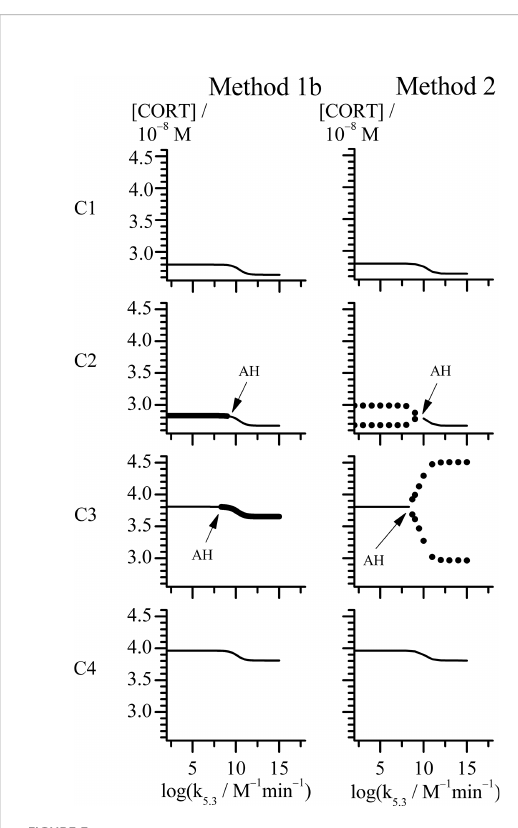
FIGURE 3 Bifurcation diagrams obtained with rate constant k 5.3 as control parameter by Methods 1b and 2 (see points C1-C4 in Figure 1). All points in case C share the same value of k 2.1 = 1 × 10 − 8 mol dm − 3 min − 1 , while for each point: C1 (k 2.2 = 11.2 × 10 − 8 mol dm − 3 min − 1 ), C2 (k 2.2 = 11.4 × 10 − 8 mol dm − 3 min − 1 ), C3 (k 2.2 = 17.6 × 10 − 8 mol dm − 3 min − 1 ) and C4 (k 2.2 = 18.6 × 10 − 8 mol dm − 3 min − 1 ). Thin line represents stable steady state (Method 1b and 2). Unstable steady states are represented by thick line (Method 1b). Minimums and maximums in oscillations of cortisol concentrations are represented by circles (Method 2). All other rate constants used in analysis had values as presented in Table 1.